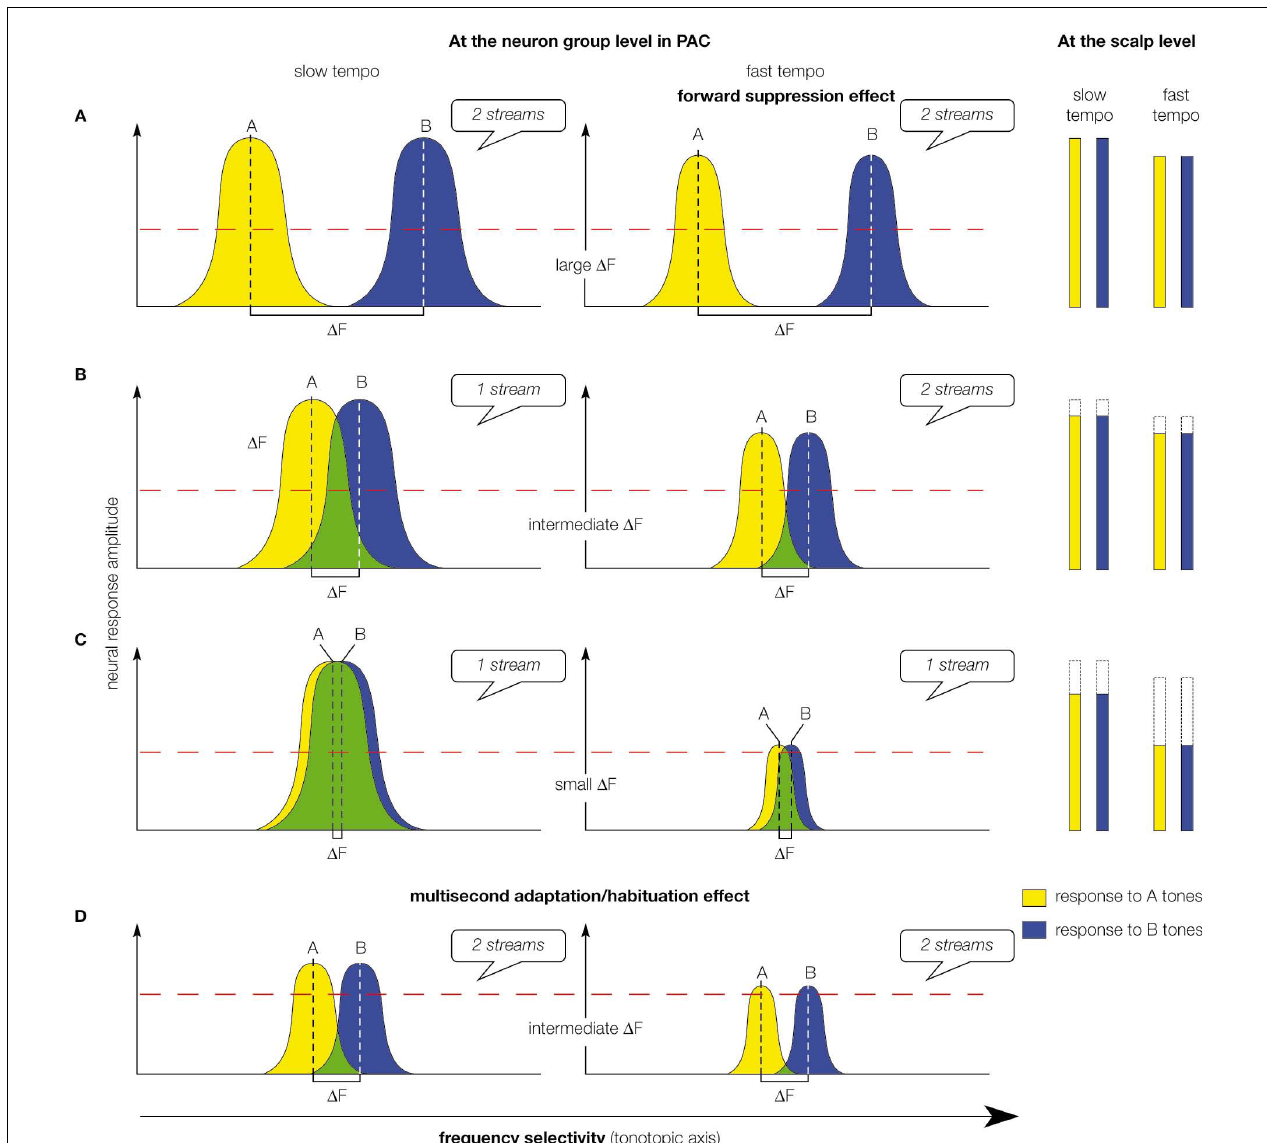
the threshold at a same location, resulting in the perception of 1 stream. When the tempo is fast, the neural responses are reduced by forward suppression, amplifying the separation between the neural populations activated by each tone. Neural responses to A and B tones do not exceed the threshold at a same location, resulting in the perception of 2 streams. (C) When the frequency separation is small, A and B tones activate largely overlapping neural populations. If the tempo is slow, neural responses to A and B tones are large and exceed the threshold at a same location, resulting in the perception of 1 stream. When the tempo is fast, the neural responses are reduced by forward suppression, but still exceed the threshold at a same location, resulting in the perception of 1 stream. (D) Multi-second habituation reduces neural responses to tones with time. Thus a sequence perceived as 1 stream at the beginning (B, left) can be perceived as 2 streams at the end [ (D) , left]. (Right panel) Amplitude of responses to A and B tones recorded at the scalp level in humans is represented with bars. Dashed lines correspond to the observed reduction of responses with decreasing frequency separation. Note that at a both tempos, responses are reduced with decreasing frequency separation. This phenomenon is not observed at slow tempo from recordings in the macaque primary auditory cortex (left